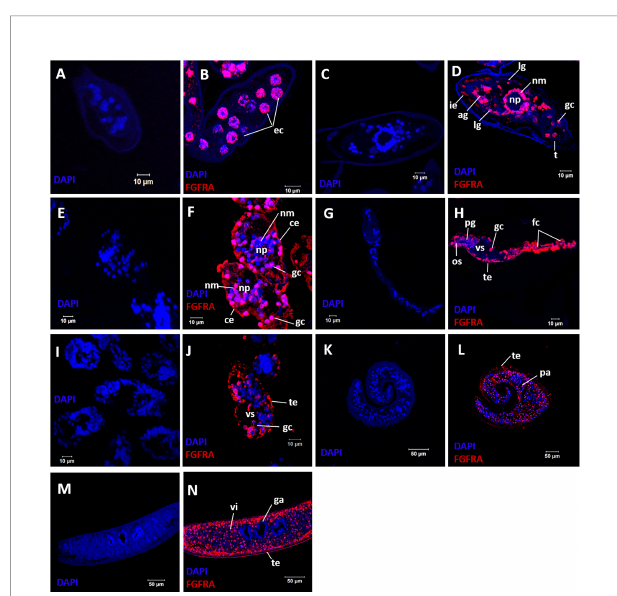
FIGURE 4 | Immunolocalization of SmFGFRA in different life cycle stages of S. mansoni . Sections of different S. mansoni stages were exposed to a mouse anti-rSmFGFRA-L antibody to examine the distribution of SmFGFRA (shown in red). Naïve mouse serum was employed as negative control. All samples were DAPI stained (in blue). Fixed immature eggs were incubated with naïve control mouse serum (A) and mouse anti-rSmFGFRA-L antibody (B) ; mature eggs were exposed to naïve control mouse serum (C) and mouse anti-rSmFGFRA-L antibody (D) ; miracidia were probed with naïve control mouse serum (E) and mouse anti-rSmFGFRA-L antibody (F) ; cercariae were incubated with naïve control mouse serum (G) and mouse anti-rSmFGFRA-L antibody (H) ; schistosomula were exposed to naïve control mouse serum (I) and mouse anti-rSmFGFRA-L antibody (J) ; adult male worms were probed with naïve control mouse serum (K) and mouse anti-rSmFGFRA-L antibody (L) ; adult female worms were exposed to naïve control mouse serum (M) and mouse anti-rSmFGFRA-L antibody (N) . ec, embryonic cells; ie, inner envelop; ig, lateral glands; ag, apical gland; nm, neural mass primordium; np, neuropile; gc, germinal cells; ce, ciliated epithelium; os, oral sucker; pg, preacetabular glands; fc, fl ame cells; te, tegument; vs, ventral sucker; pa, parenchyma; vi, vitellarium; ga,